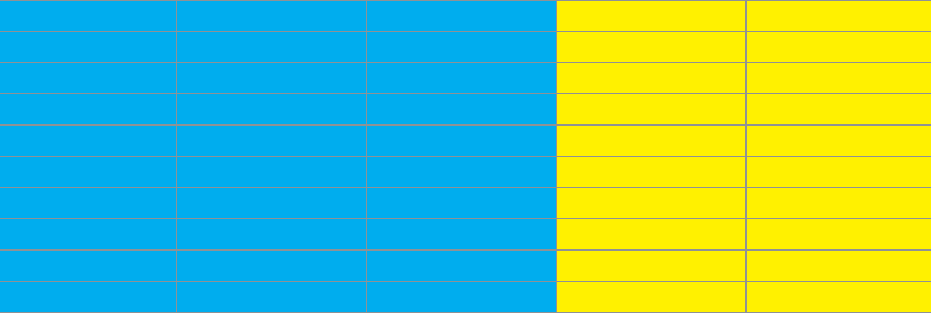
Fifty voting precincts are to be apportioned into ten contiguous districts. Each precinct is dominated by either the Cyan or the Yellow party and each precinct has approximately the same voting population.